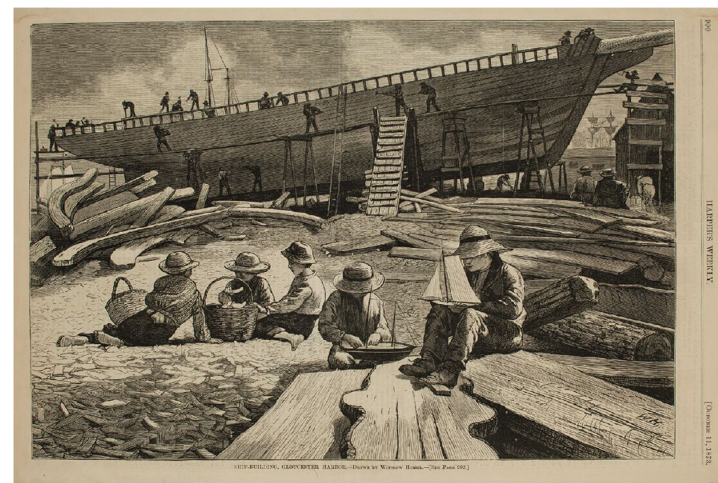
Fig. 2 Scheme for the calculation of the intermodal time distance